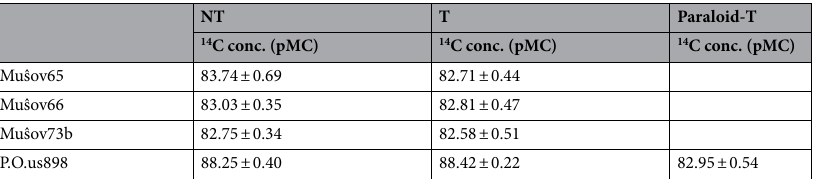
Table 3. 14 C-AMS results: radiocarbon concentrations measured in untreated (NT) and HAP treated (T) fractions. In the case of the sample from Porticus Octaviae (P.O.us898), the radiocarbon concentration measured in a Paraloid-treated sample is also